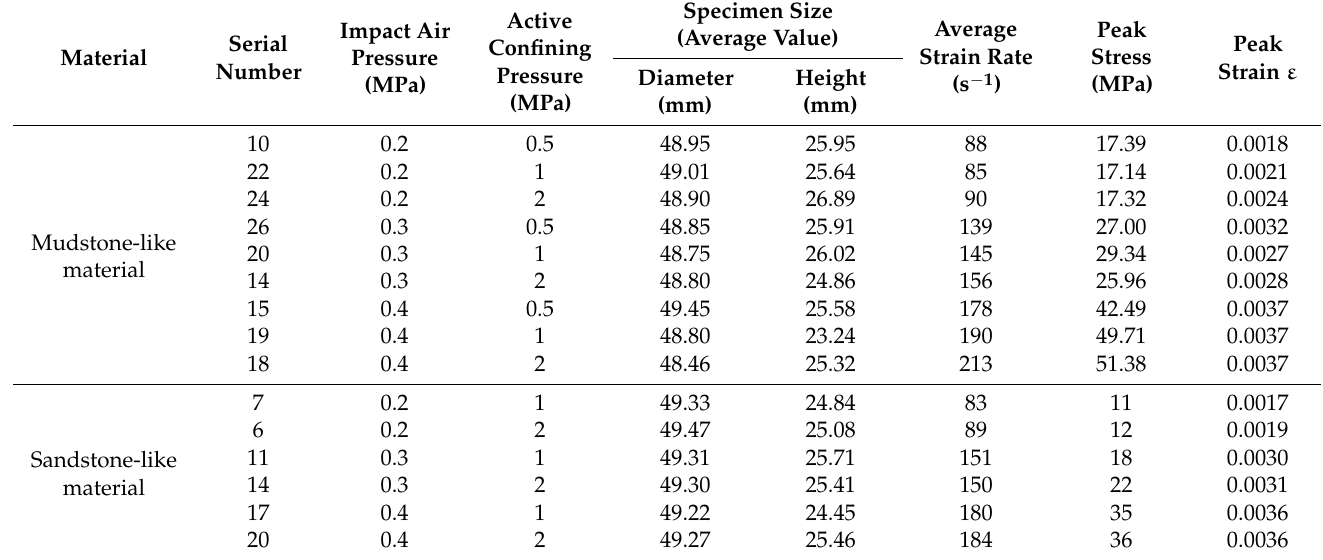
Table 6. Experimental results of active confining pressure impact of sandstone-like materials.